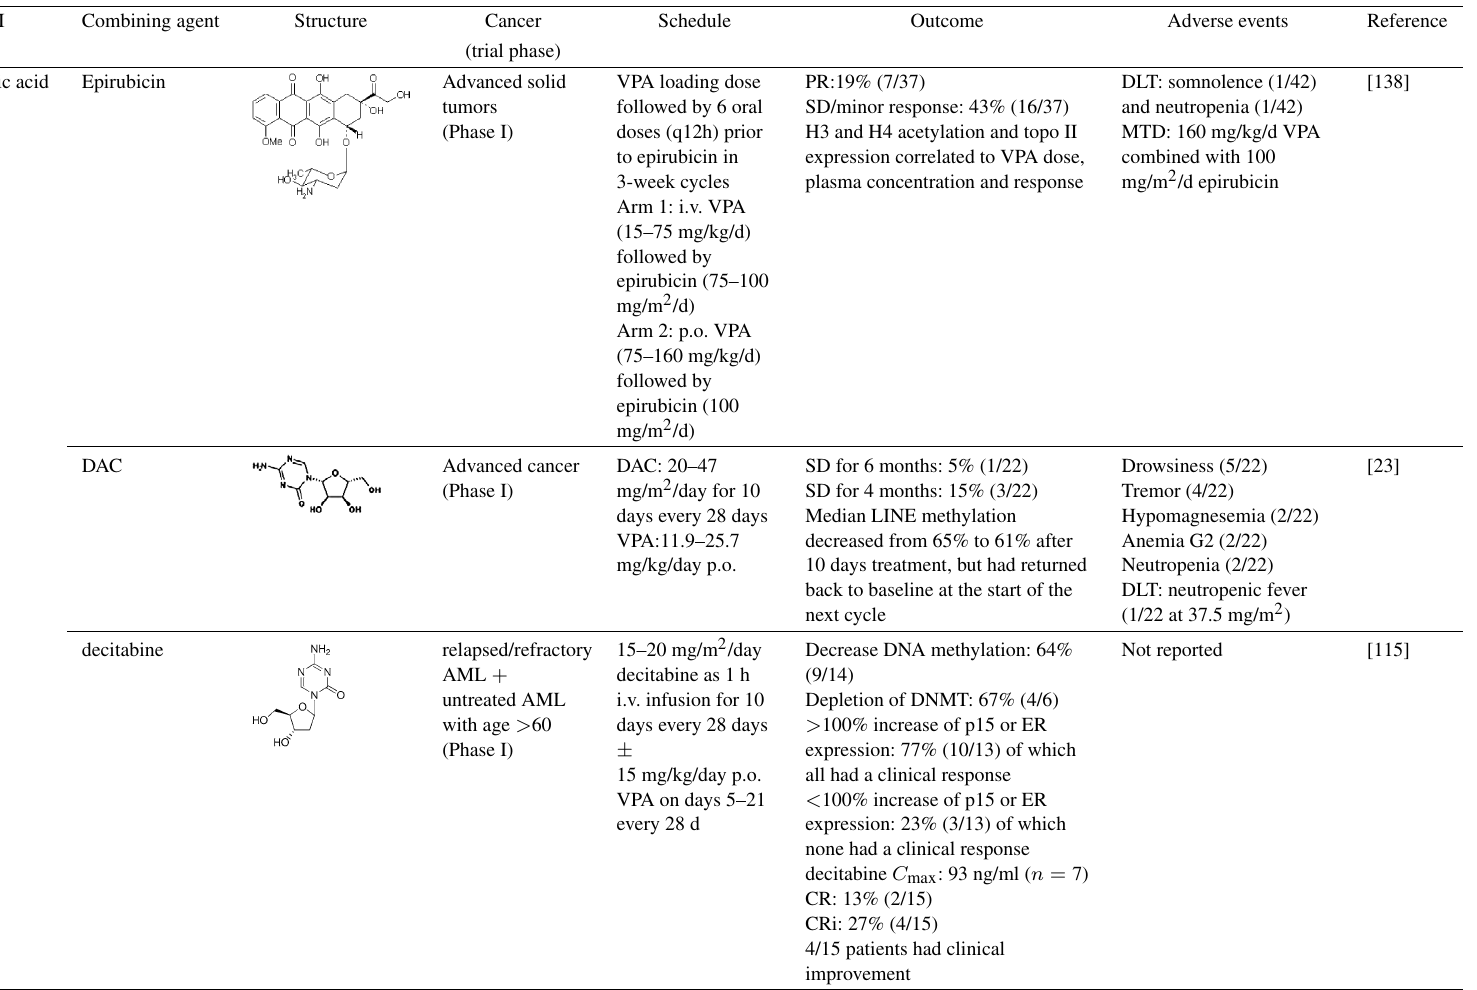
Clinical Trials of HDACIs with other